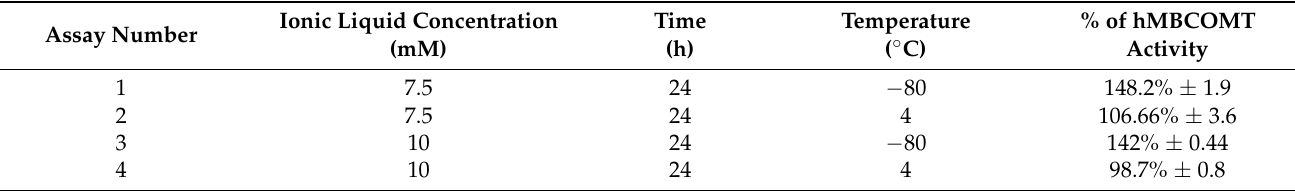
Table 2. Bioactivity recovery of hMBCOMT obtained for each condition of the DoE